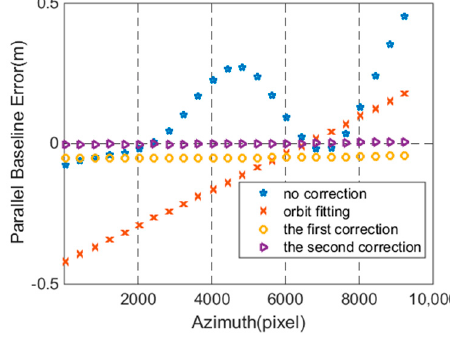
Figure 13. Parallel baseline error comparison.